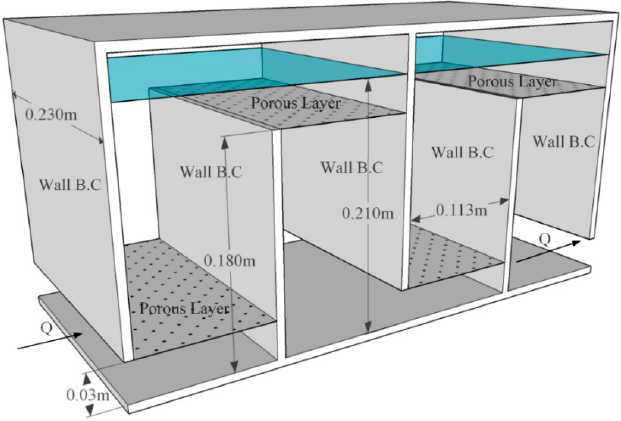
Figure 1. Configuration of the porous baffle layers in the contact tank.